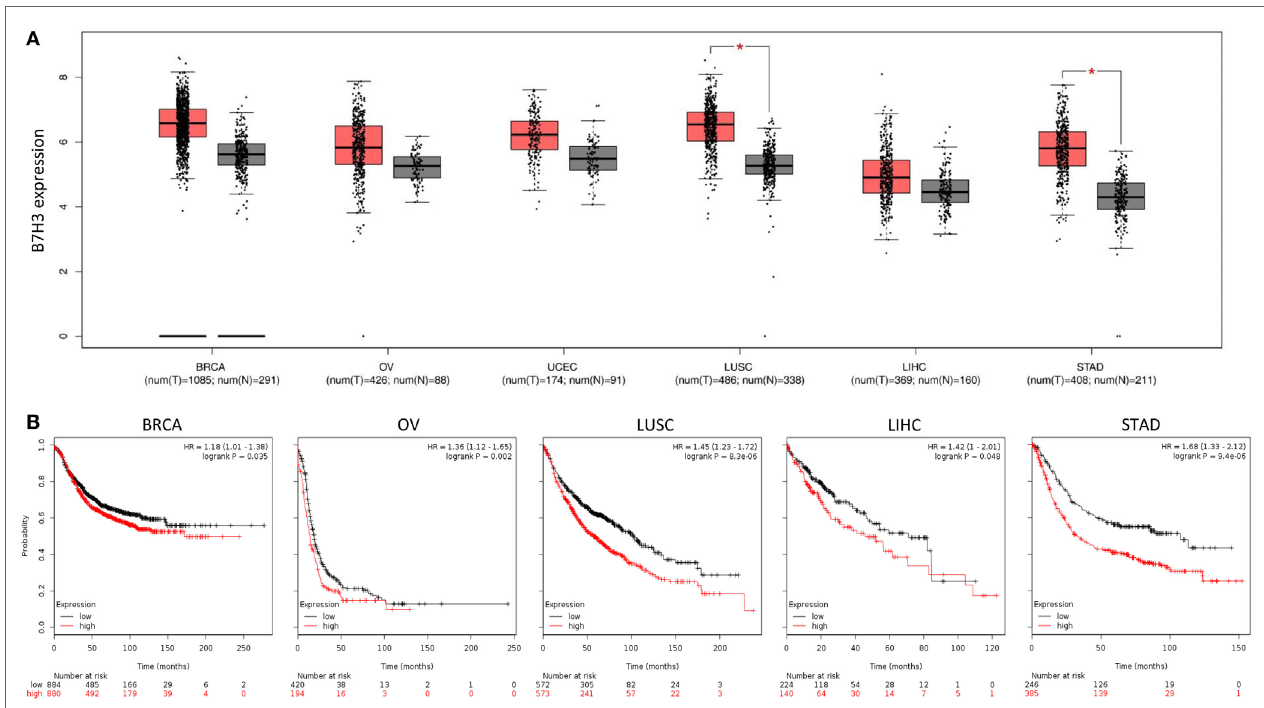
FigURe 1 | High expression of B7H3 was correlated with poorer prognosis in cancers. (A) B7H3 expression profile across TCGA pan-cancer datasets. Images were taken from the GEPIA (Gene Expression Profiling Interactive Analysis) online database (http://gepia.cancer-pku.cn). N, normal; C, cancer. * P < 0.05. (B) Kaplan–Meier curves for overall survival in indicated cancer types using the Kaplan–Meier Plotter database (www.kmplot.com). Red and black lines indicate patients with higher and lower than median B7H3 mRNA expression, respectively. High expression of B7H3 was significantly correlated with shorter overall survival in each Kaplan–Meier plotter cohort. BRCA, breast invasive carcinoma; OV, ovarian serous cystadenocarcinoma; UCEC, uterine corpus endometrial carcinoma; LUSC, lung squamous cell carcinoma; LIHC, liver hepatocellular carcinoma; STAD, stomach